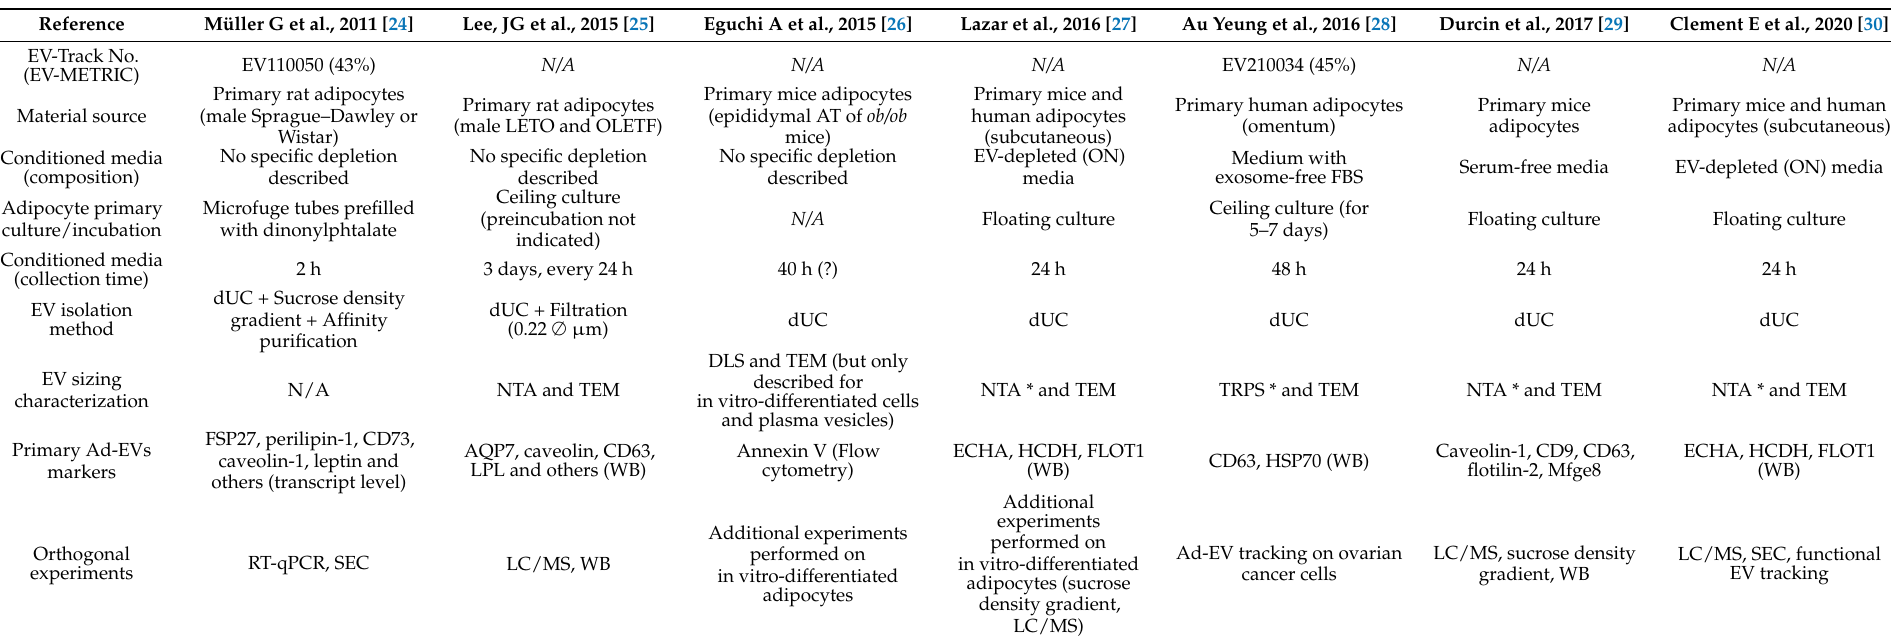
Table 1. Overview of currently published references working on Ad-EVs obtained from primary isolated